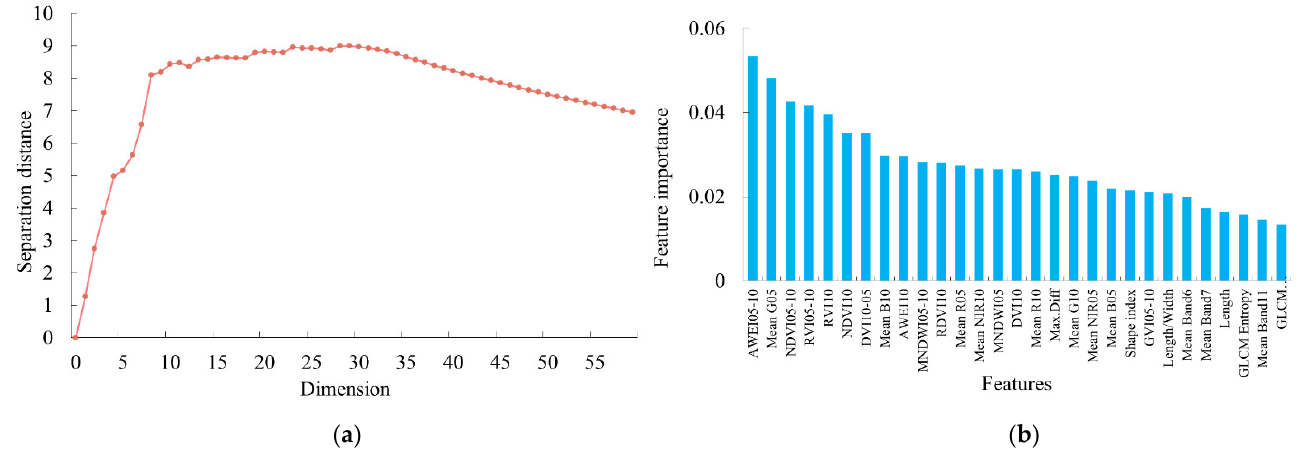
Figure 7. Number of features and importance of each feature in the optimal feature set. ( a ) ROC